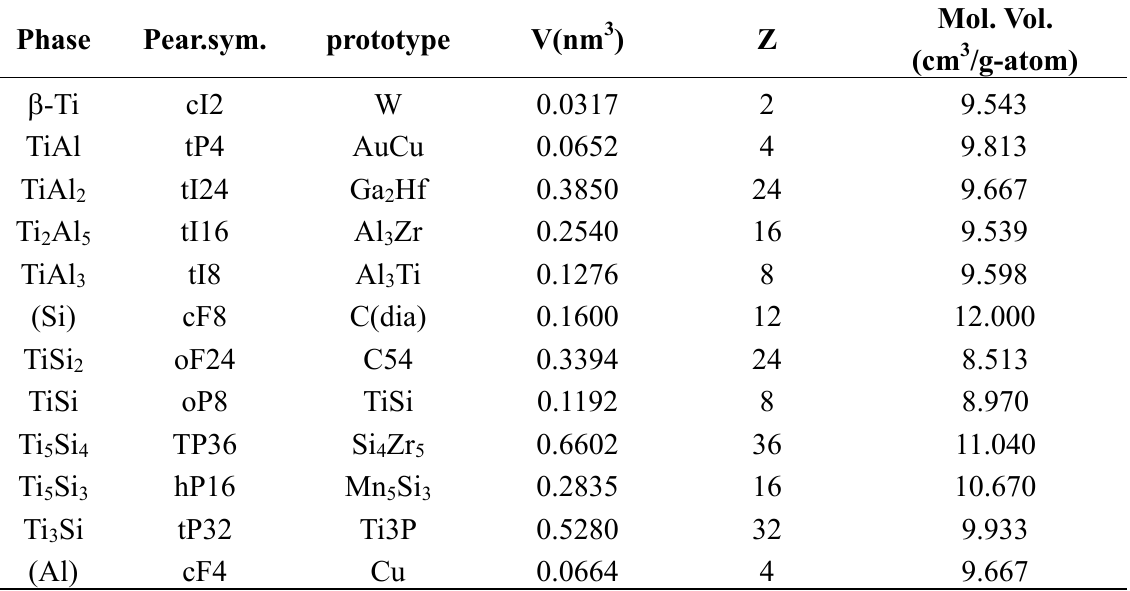
Table 4. The Crystal structures and molar volumes of the Titanium alluminides and Titanium silicides (V: volume of the unit cell, Z : Number of formula units in the unit cell) [7]. Phase